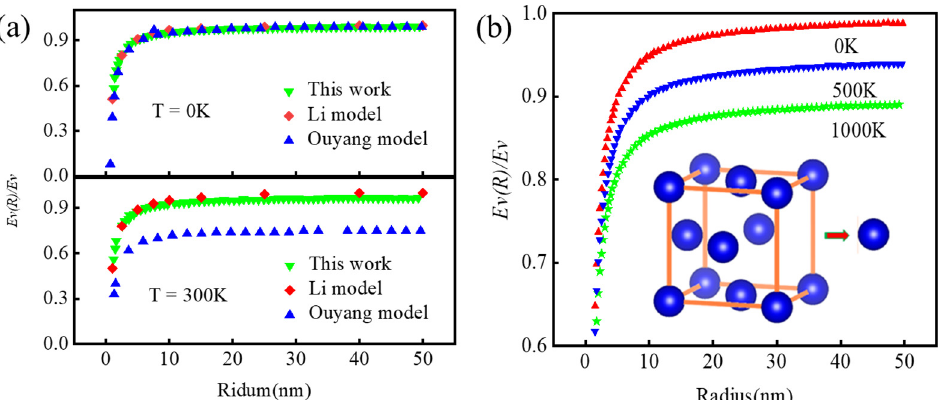
Figure 5. Effect of particle size and temperature on the vacancy formation energy of AuNPs: (a) comparison with other models at 0 K and 300 K; (b) predicted trends at 500 K and 1000 K. (The detailed calculation parameters: Um (b,0) is the internal energy at 0 K, Cp is the specific heat capacity at constant pressure, and the relevant can be found in the supplementary materials Tables S12 – S14.)